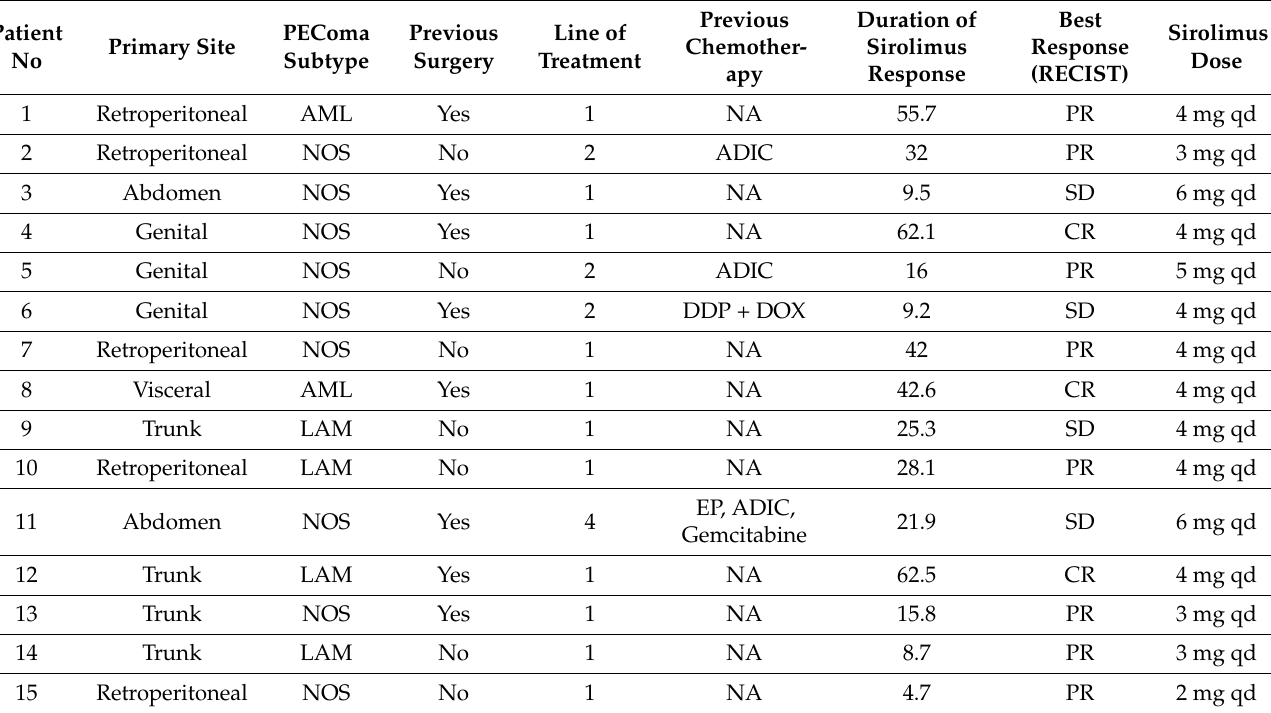
Figure 2. Patient with massive peritoneal effusion due to retroperitoneal LAM ( A , B ) and response to treatment with sirolimus ( C , D ). Table 1. Summary or patients characteristics.